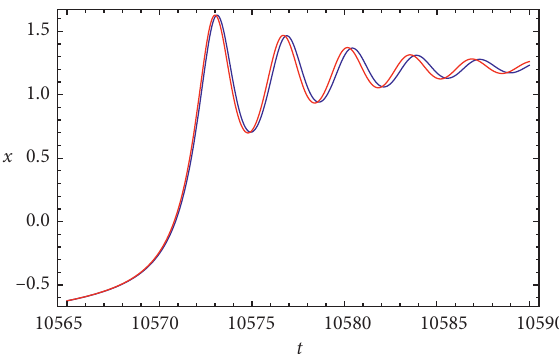
Figure 16: Time history of system (36). The red line represents the curve before time-delay approximation, and the blue line repre- sents the curve after time-delay approximation when the param- � 0 . 01 ,f � 1, and τ � 0 . 3 eters are a � b � α � 1 , ω 2 1